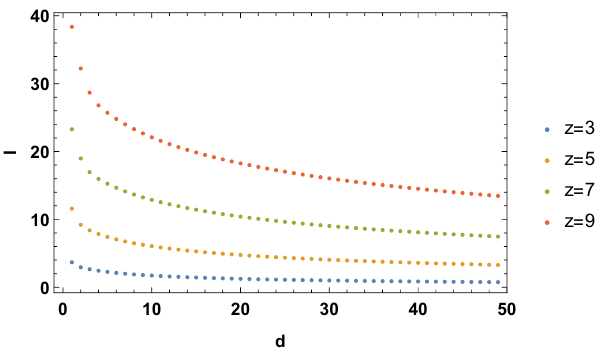
Figure 7 . Mutual information as a function of the separation between subregions for di(cid:11)erent values of dynamical exponent for a = b = 20, m = 0 and N =